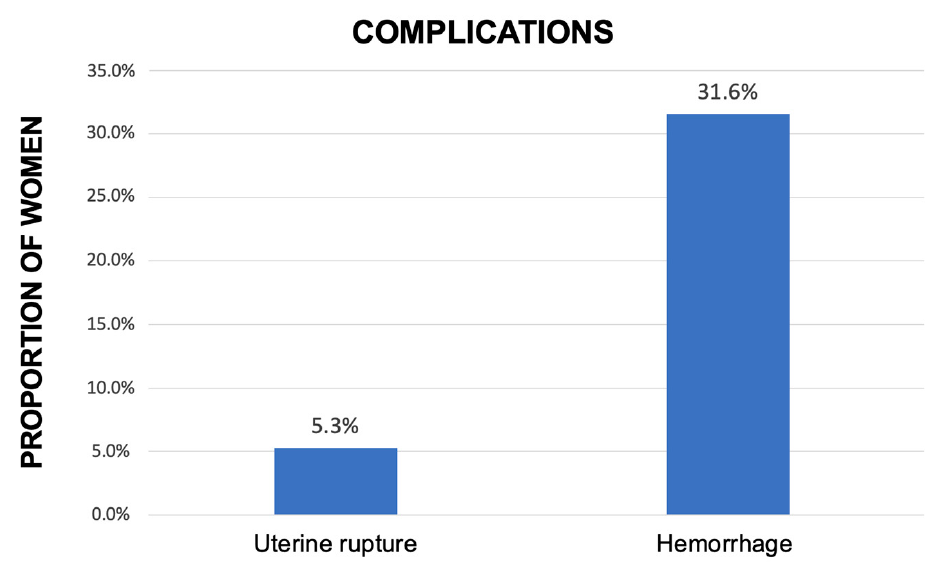
Figure 2. Rate and type of complication among the patients treated with both methotrexate injection and subsequent hysteroscopic resection (expressed in percentage, %).